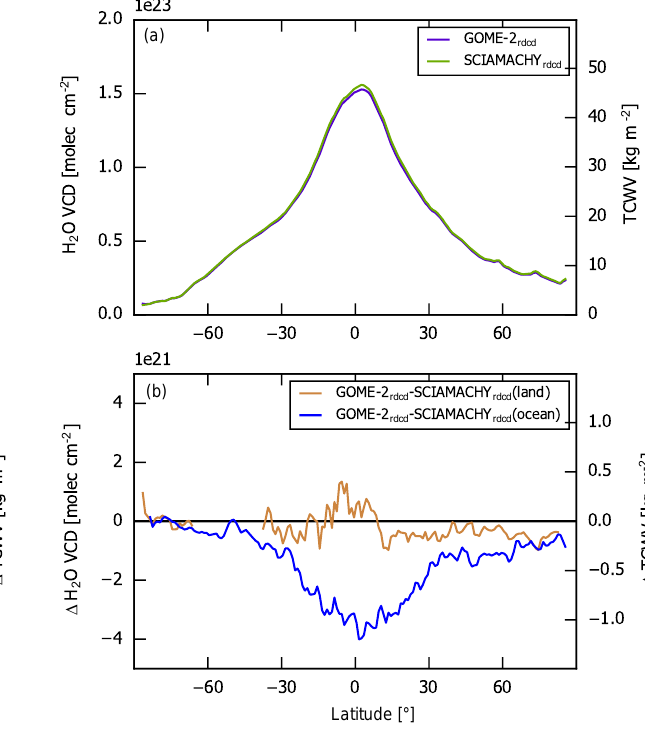
Figure 6. Zonal mean of TCWV for GOME-2 and SCIAMACHY (a) and the respective differences, separately for land and ocean (b) , as a function of